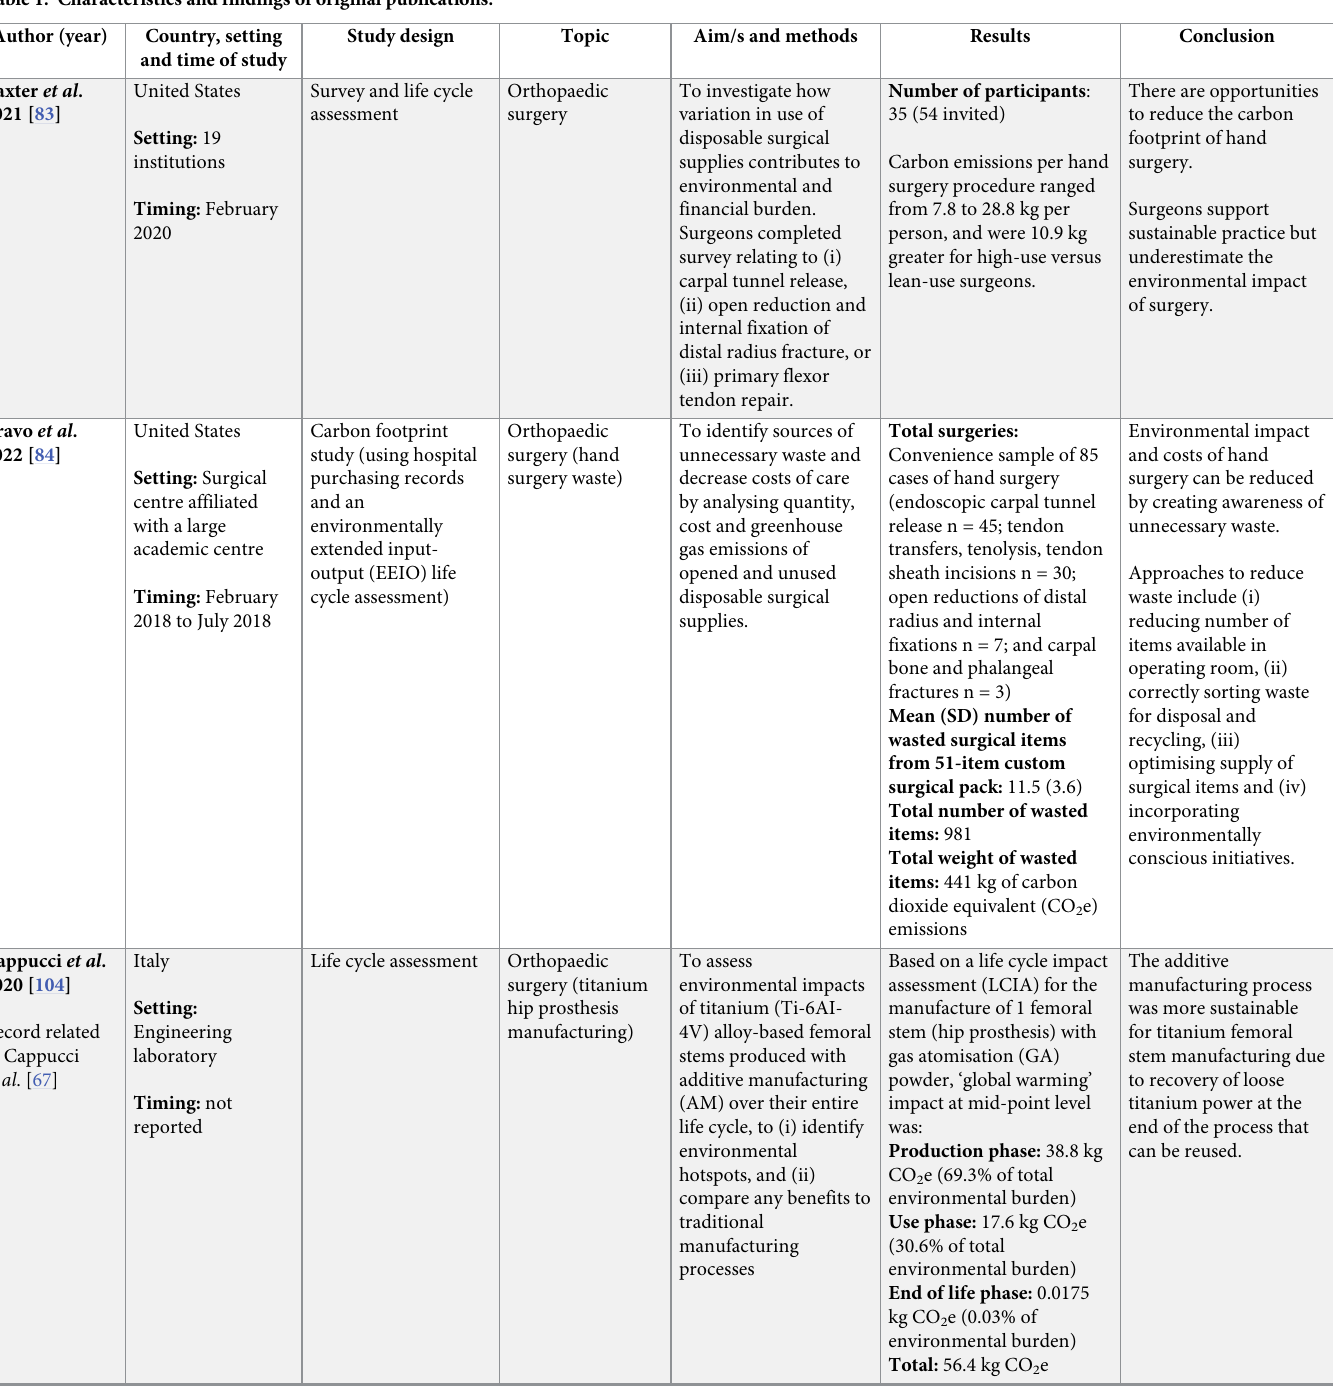
Table 1. Characteristics and findings of original